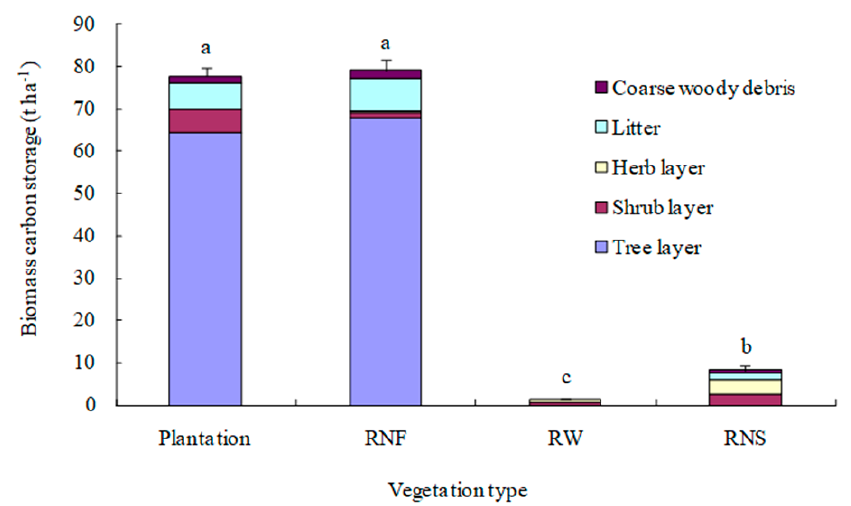
Figure 3. Biomass carbon storage of different vegetation types.